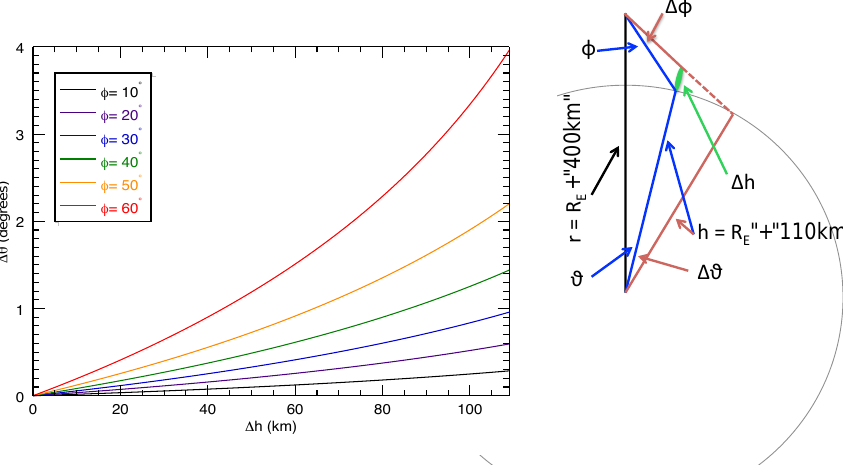
Figure 10. Each trace is the calculated angular extent of projected features ( (cid:49)θ ) as a function of the altitude extent of the auroral emission ( (cid:49)h ) for a given value of the angle of line-of-sight away from nadir ( φ ). The geometry is drawn to the right, where the grey circle represents the geocentric distance of the assumed auroral emission (taken to be h = R E + 110km). The green vertical line represents a discrete auroral feature with vertical extent (cid:49)h above h . The black vertical line represents the geocentric position vector of the ISS, r . The short blue line represents the line of sight from the ISS to the base of the auroral form, and the angle this line makes with nadir is given by φ . The longer blue line is the position vector of the base of the auroral form and has an angular separation from the position vector of the ISS of θ . The shorter red line represents line of sight from the ISS to the top of the auroral form and its extension (dashed) to its intersection point with the height of assumed auroral emission. The longer red line then represents the position vector of this intersection point and thus the angle between it and the longer blue line ( (cid:49)φ ) is the angle over which the feature would be projected in the georeferenced image.